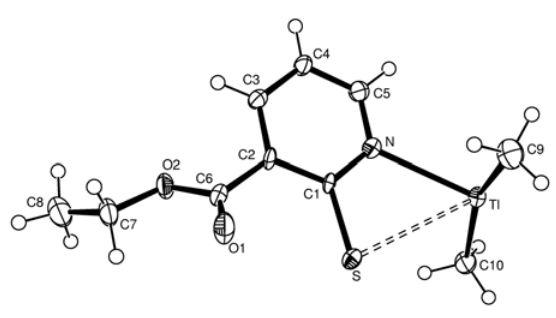
Fig. 4 ORTEP plot of the asymmetric unit in [TlMe 2 (2men)]( 3 ).